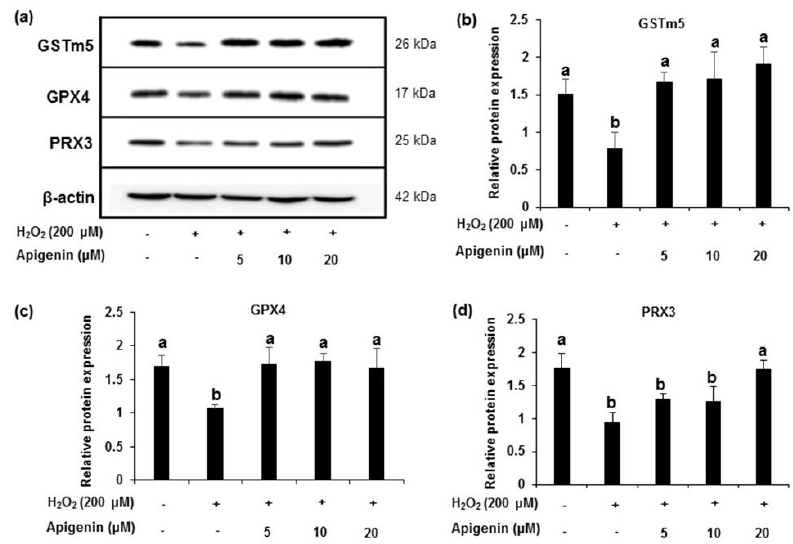
Figure 4. The effect of apigenin on the antioxidant enzyme protein expression level in H 2 O 2 -exposed cells. ( a ) The protein expression of GSTm5, GPX4 and PRX3 in H 2 O 2 -exposed GC-2spd cells was analyzed using Western blotting. Cell lysates from each groups were immunoblotted with specific antibodies. ( b – d ) The protein band intensity of GSTm5, GPX4 and PRX3 in H 2 O 2 -exposed GC-2spd cells, respectively, normalized to that of β -actin is shown. The data represent the mean ± standard deviation. The groups of control, H 2 O 2 , and different concentrations of apigenin were compared with each other and letters on the top of the columns that do not share the same letters are statistically significant among the groups ( p < 0.05) by one-way ANOVA. GSTm5, glutathione S-transferase m5; GPX4, glutathione peroxidase 4; PRX3, peroxiredoxin 3.